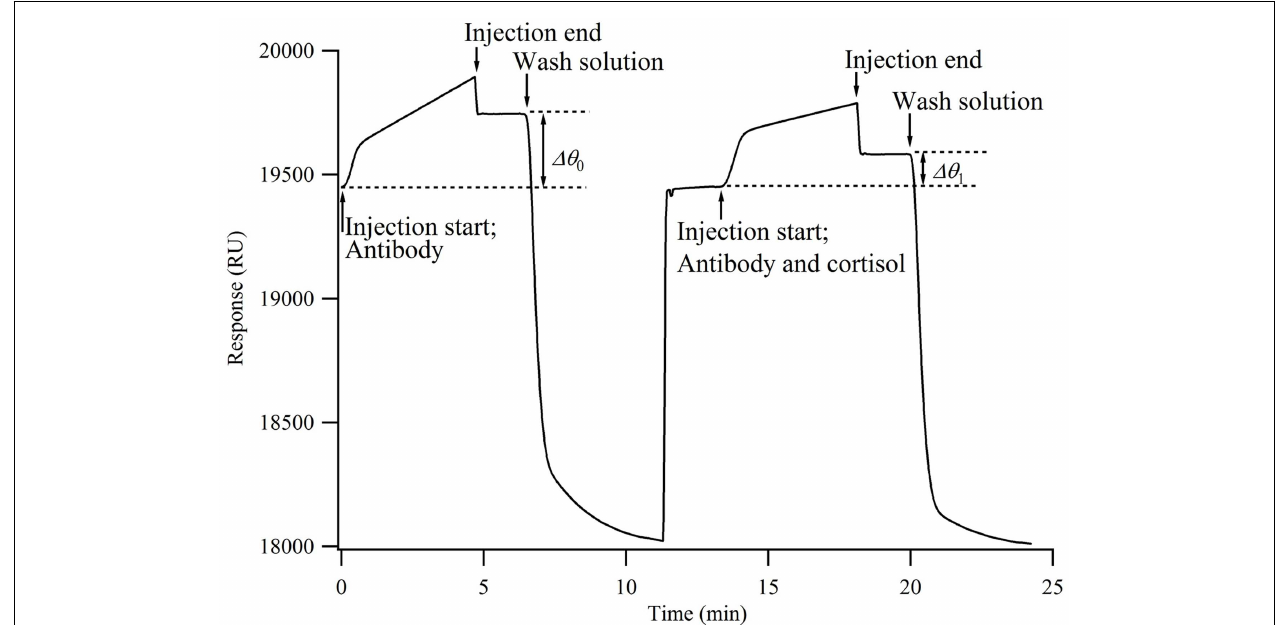
FIGURE 2 | Surface plasmon resonance sensorgram obtained from indirect competitive assay .